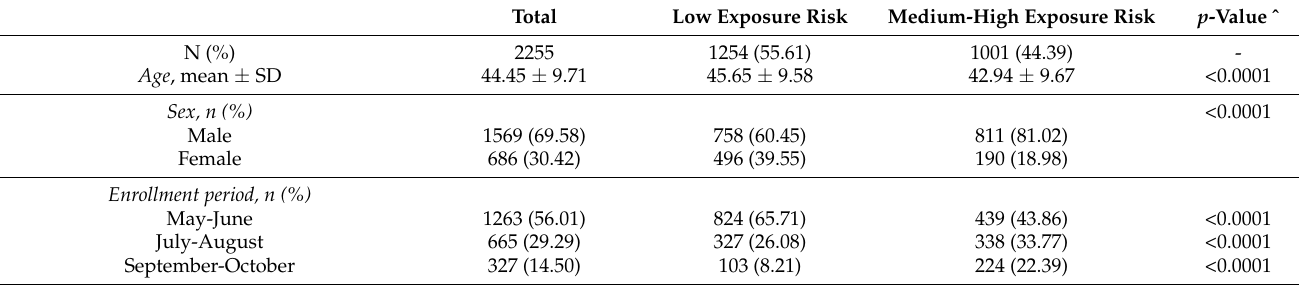
Figure 1. The study flow diagram. Table 1. Characteristics of the study